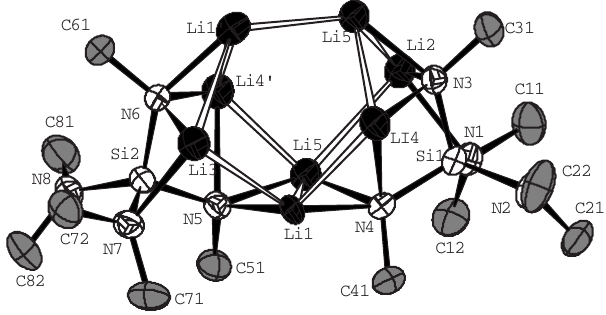
Table 2. Atomic coordinates and displacement parameters (in Å 2 )